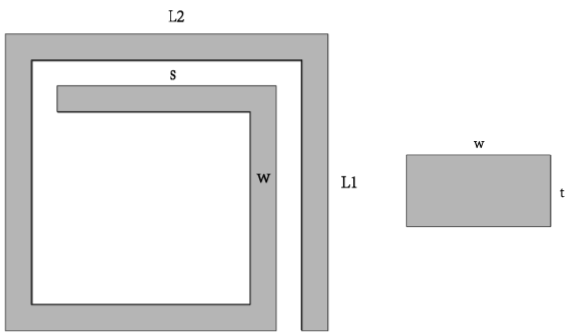
Figure 2. Parameters of the suspended inductor.